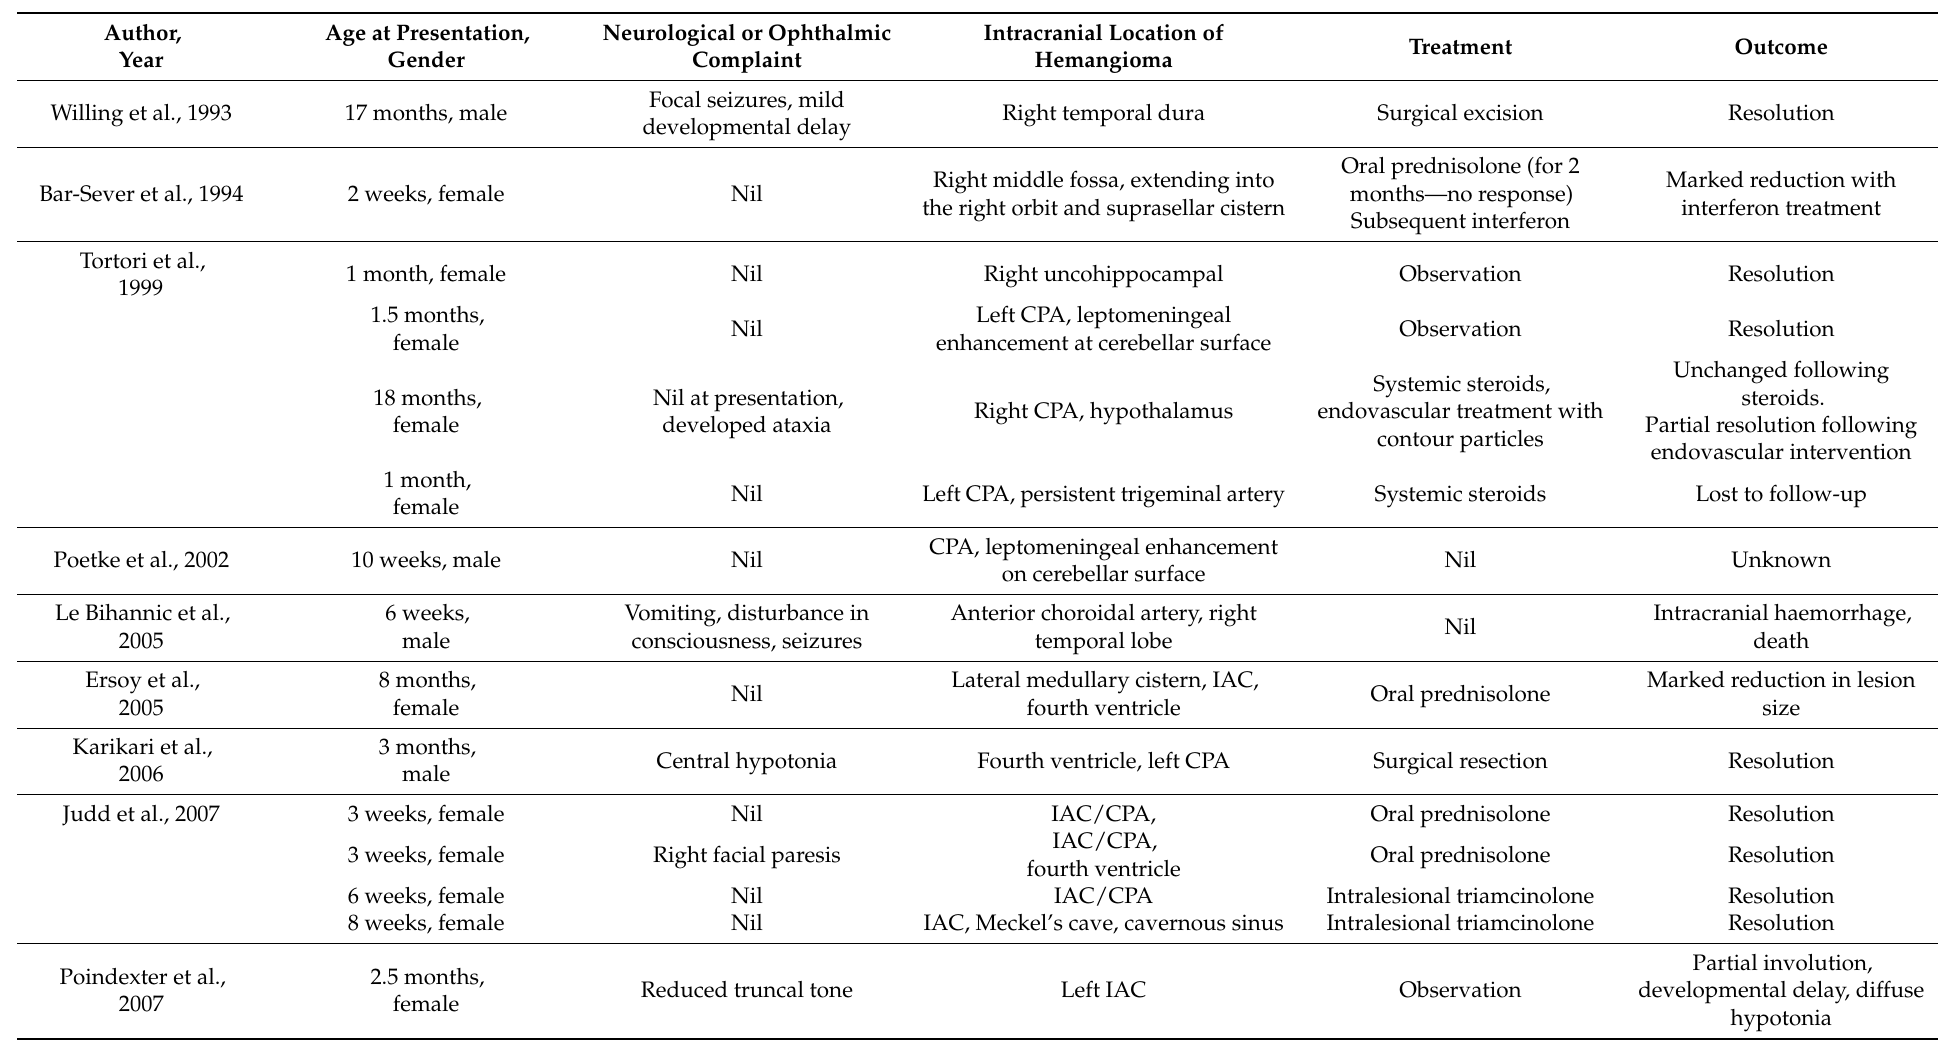
Table 1. Cases of intracranial infantile